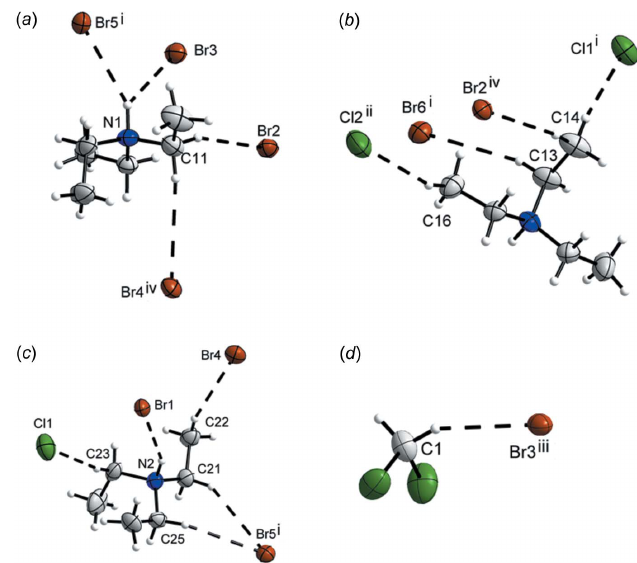
Figure 2 The hydrogen bonds and hydrogen-bond-like interactions (dashed lines) present in the structure of the title compound. ( a ) and ( b ) show the interactions of the HNEt + cation with N1, ( c ) of the HNEt + cation with N2, and ( d ) shows the interactions of DCM. Displacement ellipsoids within each subfigure are shown at the 70% probability level at 100 K and H atoms are drawn with an arbitrary radius. See Table 2 for symmetry operators.